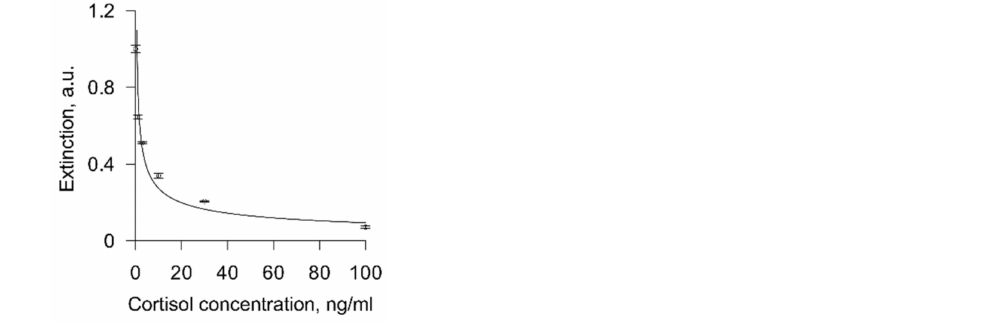
Figure 7. Calibration graph of the enzyme immunoassay ( n = 3). Curve fitting equation: